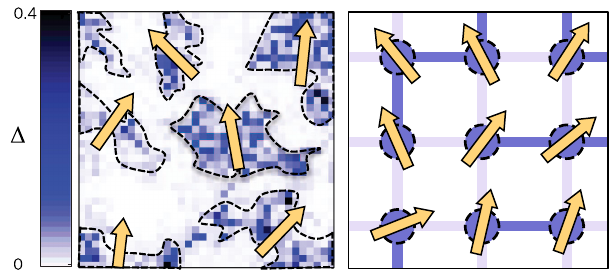
FIG. 1. The emergent inhomogeneity of the local pairing amplitude Δ ð r Þ in a disordered superconductor in the left panel and the robustness of the single-particle gap [8 – 10] across the SIT suggest an effective low-energy description in terms of a disordered quantum XY model shown on the right. The quantum phase transition occurs when long-range phase coherence is lost between weakly connected “ superconducting islands ” tuned by the ratio E c =E J of charging energy to Josephson coupling as well as by disorder, modeled by removing a fraction p of the Josephson